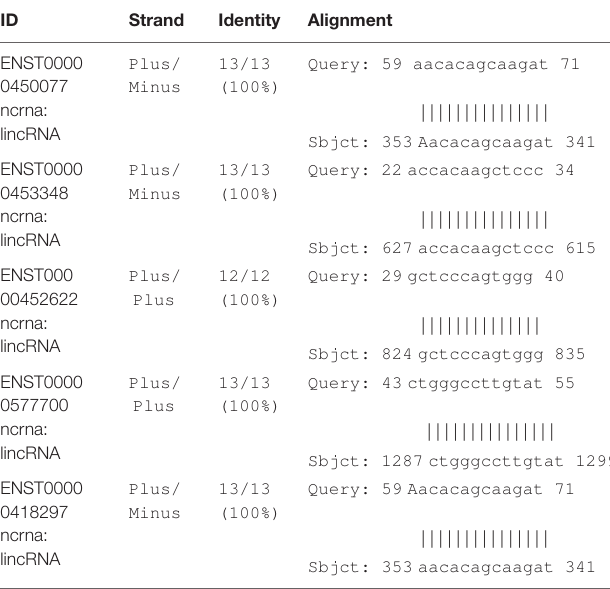
TABLE 6 | List of DDP6 possible binding candidates of lncRNAs.